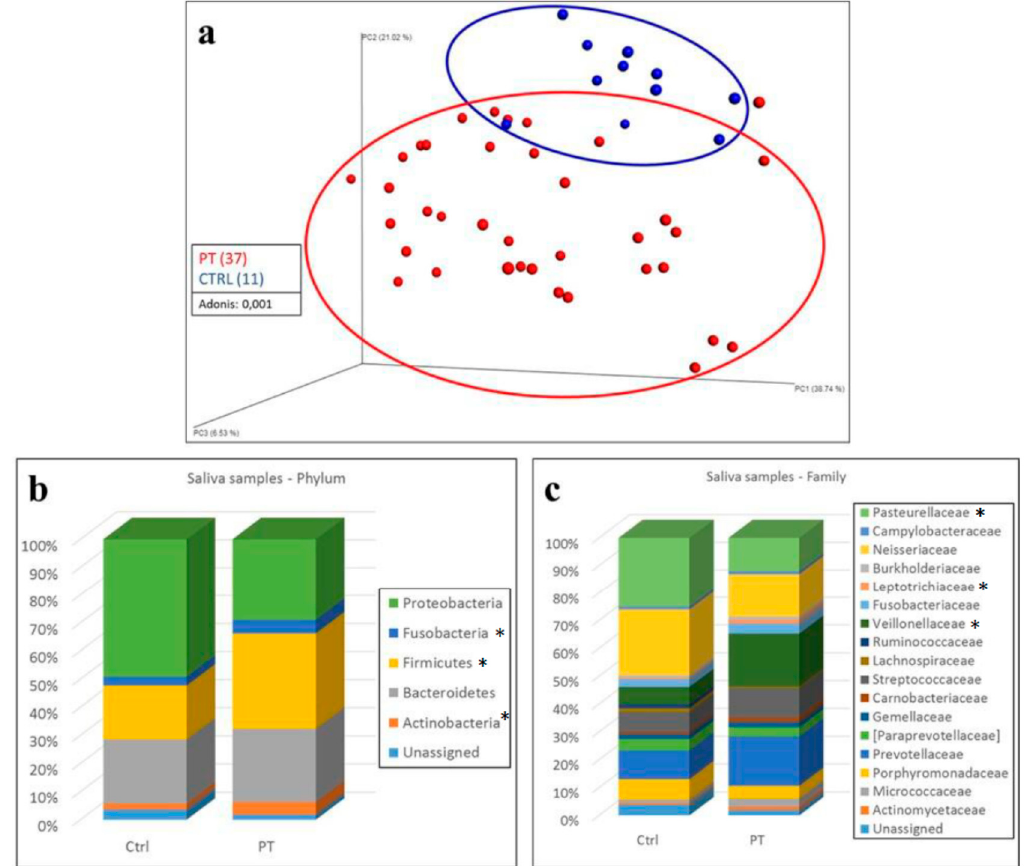
Figure 2. Analysis of salivary samples. ( a ) Beta diversity analysis of salivary samples with respect to subject status: Lynch syndrome patients = PT (red); control subjects = CTRL (blue). Weighted UniFrac distance metric and principal component analysis were used to perform beta-diversity analysis. A cluster can be observed between the two groups, confirmed by Adonis analysis ( p : 0.001). Statistical analysis: Adonis. Statistical significance: p < 0.05. ( b , c ) Taxonomic composition of oral samples from Lynch syndrome patients (PT) and control subjects (CTRL) at phylum ( b ) and family ( c ) levels. Relative bacterial abundances are expressed as average percentage. * Statistical significance: p < 0.05.